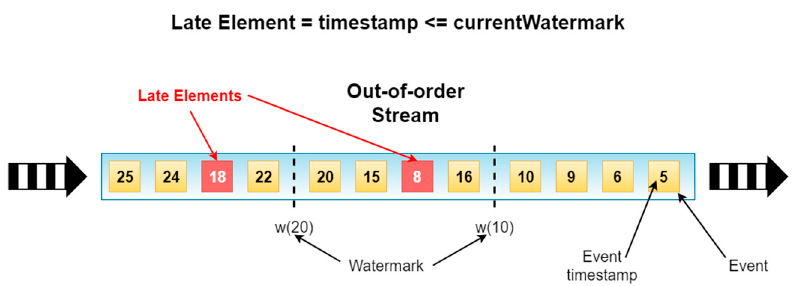
Figure 8. Late elements detection through the watermarking mechanism.